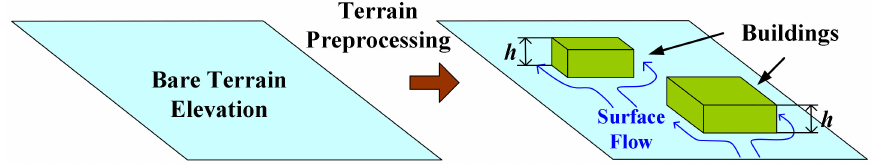
Figure 1. Terrain preprocessing method used in